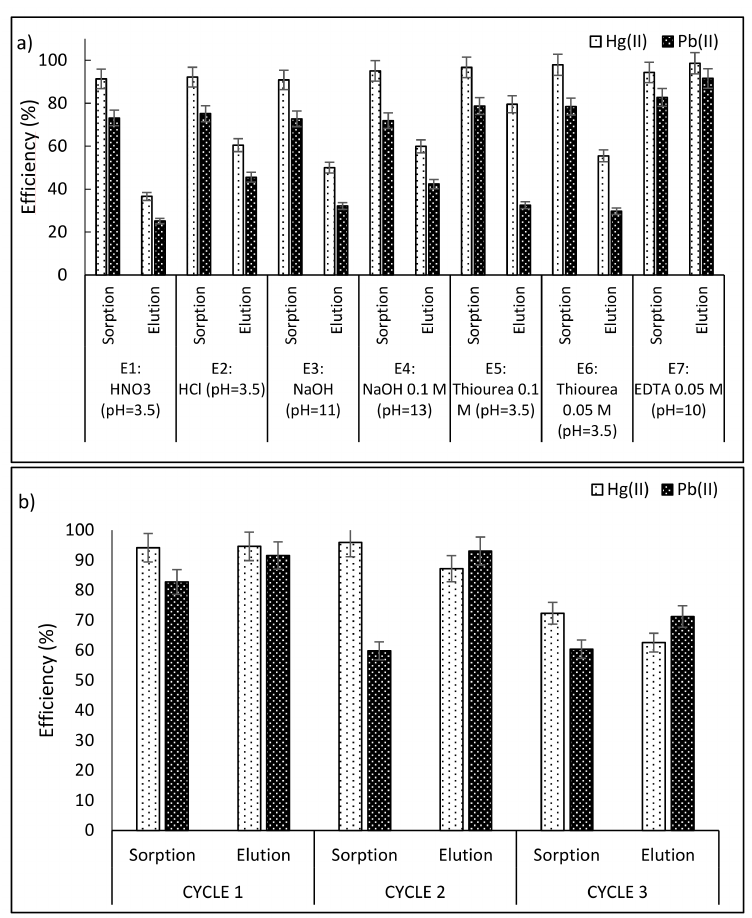
Figure 10. Desorption: ( a ) Eluent selection, ( b ) Cycles with the selected eluent: EDTA solution pH 10. ( T : 20 ◦ C; sorbent dosage: 1 g · L − 1 ; agitation speed: 180 rpm; contact time: 24 h; C 0 : 0.15 mmol · L − 1